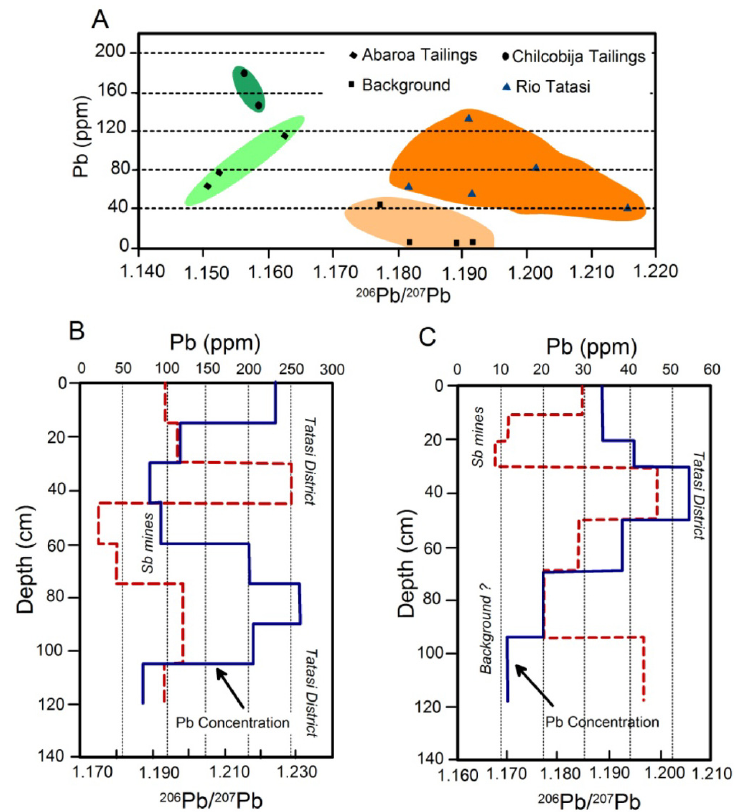
Figure 12. Pb from the local geological units, as well as from Abaróa, Chilcobija, and Rio Tatasi mines can be fingerprinted on the basis of total Pb concentrations and 206 Pb/ 207 Pb ratios ( A ). The defined geochemical fingerprints can be used to assess changes in Pb contributions to the river system through time as recorded in floodplain deposits sampled at two different sites ( B , C ) (from Villarroel et al.